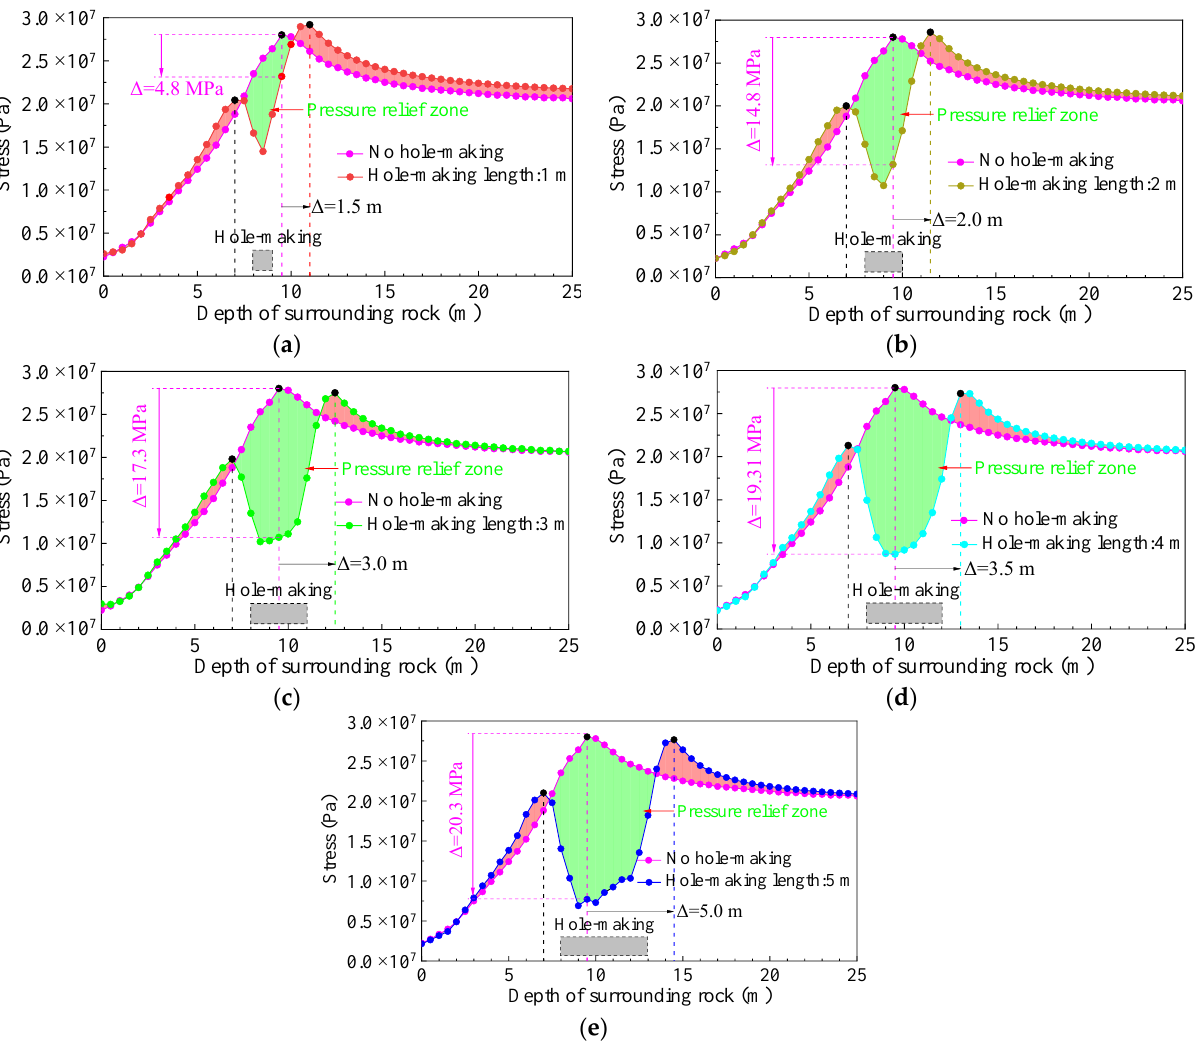
Figure 14. Comparison of the roadway rib stress curves with different hole-making lengths. ( a ) Hole-